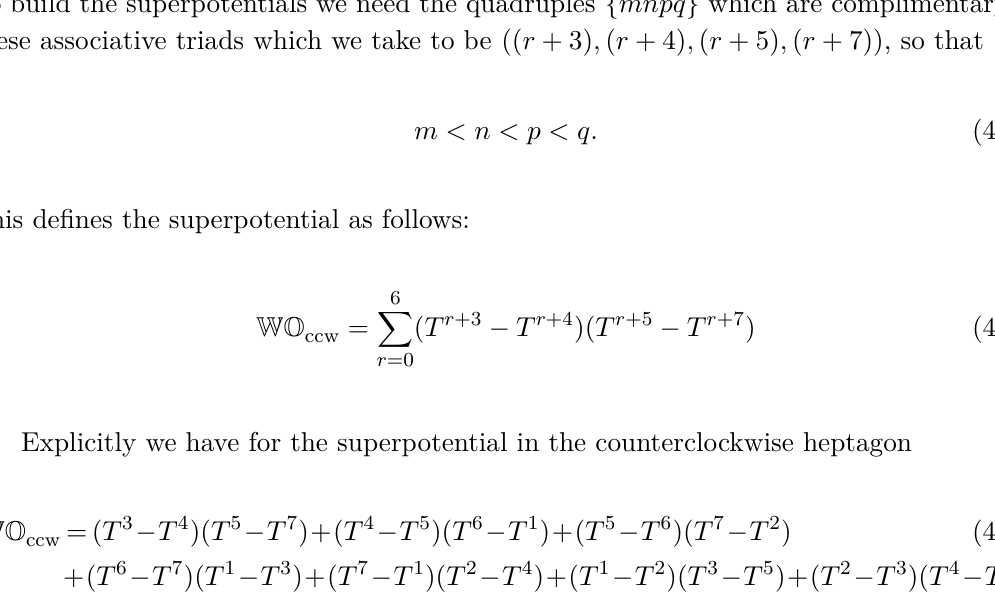
on the counterclockwise ccw